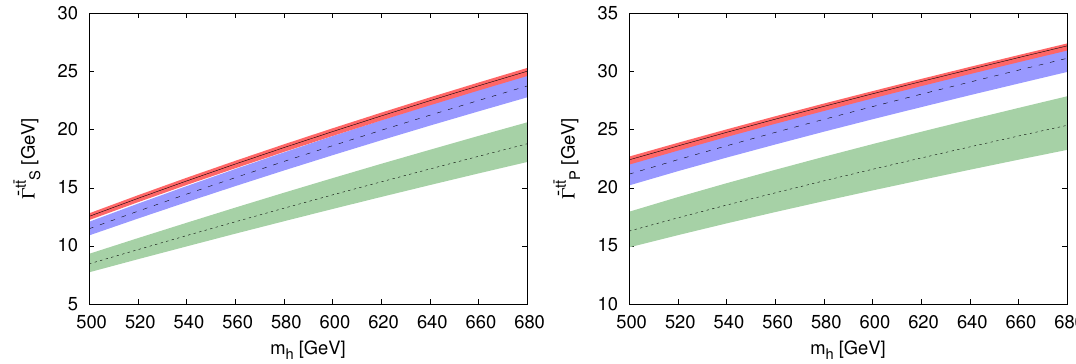
Figure 2 . Left plot: the decay width into t (cid:22) t of a scalar Higgs boson with a t = 1 at LO (short-dashed, green), NLO (long-dashed, blue), and NNLO (solid, red) QCD as a function of the Higgs-boson mass. The short-dashed, long-dashed, and solid lines correspond to the scale choice (cid:22) = m h while the shaded bands show the e(cid:11)ect of varying the renormalization scale between m h = 2 and 2 m h . Right plot: same as left plot, but for a pseudoscalar Higgs boson with b t = 1.